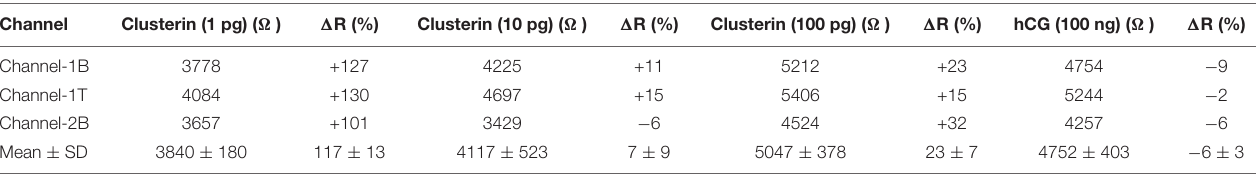
TABLE 3 | Measured resistance and resistance change (%) for Clusterin (1 pg/mL) to hCG (100 ng/mL) stages of analyte detection for the three channels and the corresponding mean and standard deviation values. Channel